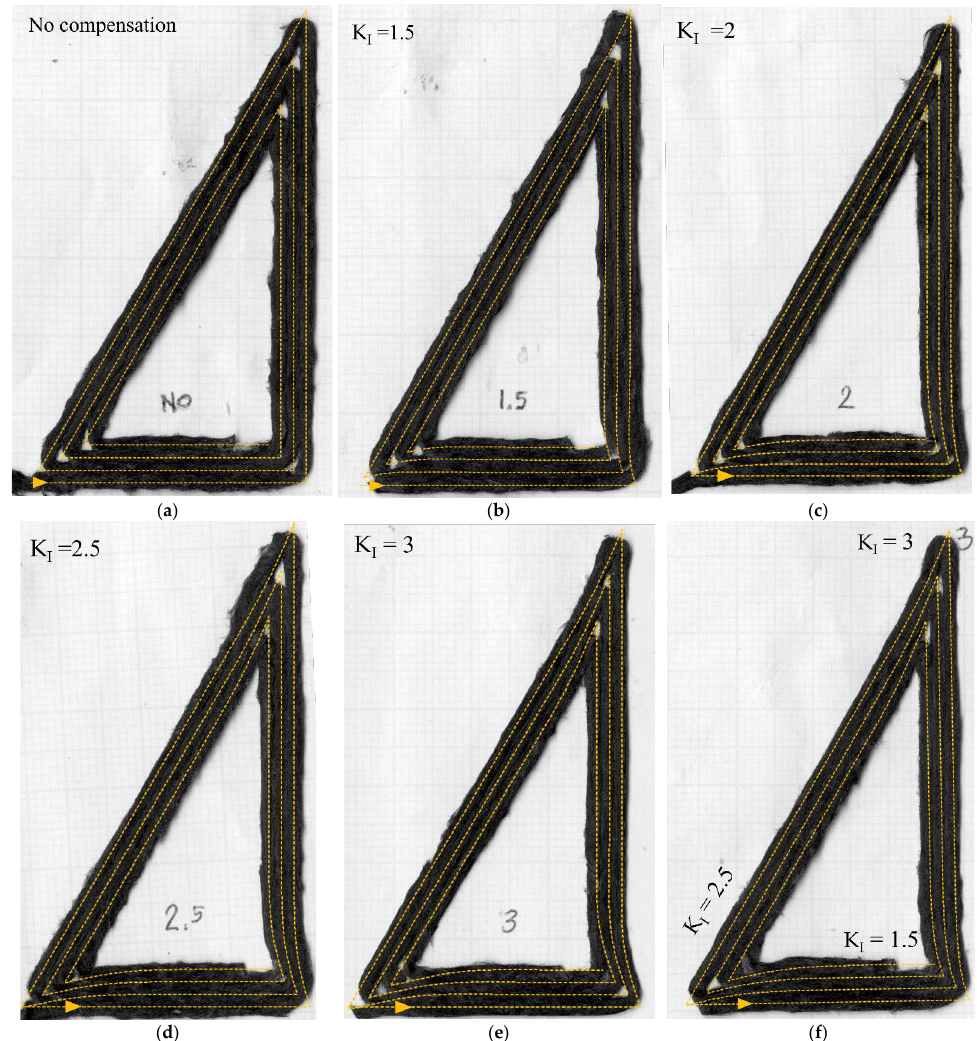
Figure 9. Triangle deposited rasters: ( a ) without compensation; ( b – e ) after path compensation with different levels of K I from 1.5 to 3; and ( f ) with varied K I ( K I =1.5 at 90°, 2.5 at 120°, 3 at 150° turning angle).